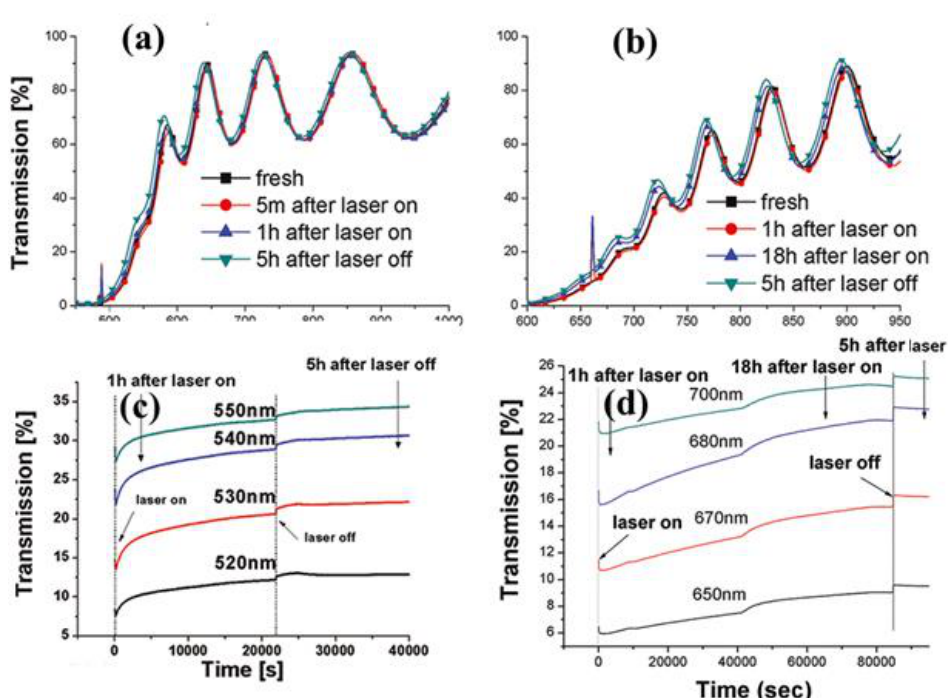
and ( b ) Ge Se films when illuminated in the air. Time 2 2 3 and ( d ) Ge Se thin films 2 2 3